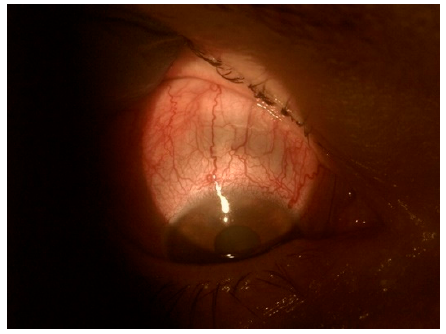
Figure 2. Translucent sclera with visible blue-black uveal tissue.